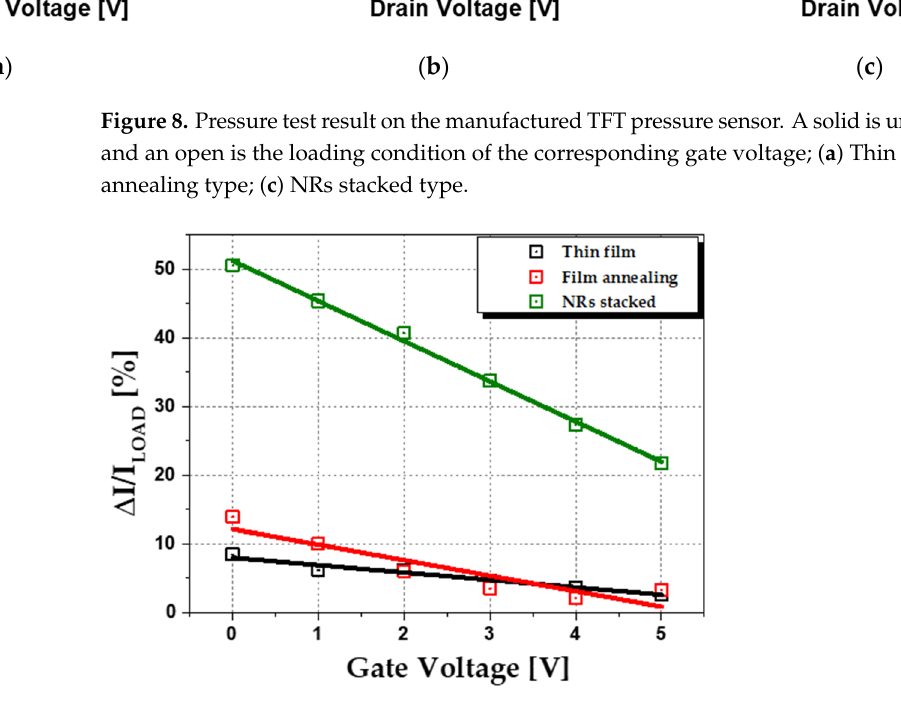
Figure 9. Ratio of response current results according to gate voltage extracted from the measurement of the fabricated ZnO TFT pressure sensor. Table 4. Comparison of response current ratio according to TFT back gate voltage control. Gate Voltage